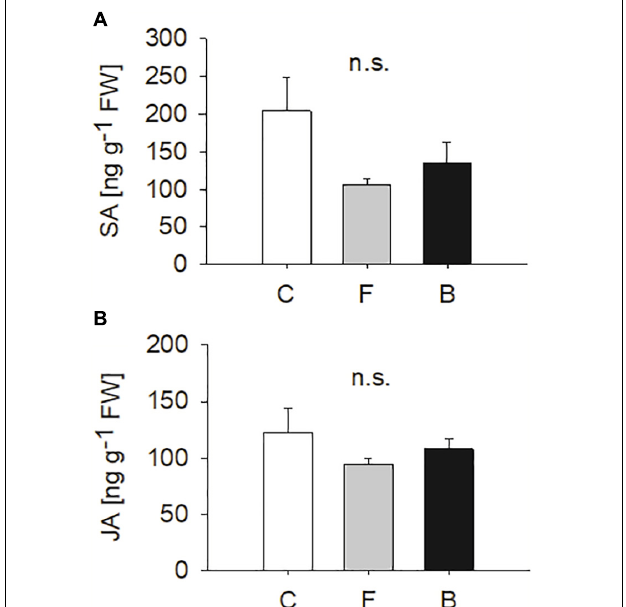
FIGURE 7 | Levels of salicylic acid (A) and jasmonic acid (B) (means ± SE) measured in B. bassiana colonised (F, FRh2 and B, BG11) and control (C) A. thaliana . Error bars represent the standard error of the mean ( N = 6), bars with different letters differ significantly ( P < 0.05). n.s., not significant.